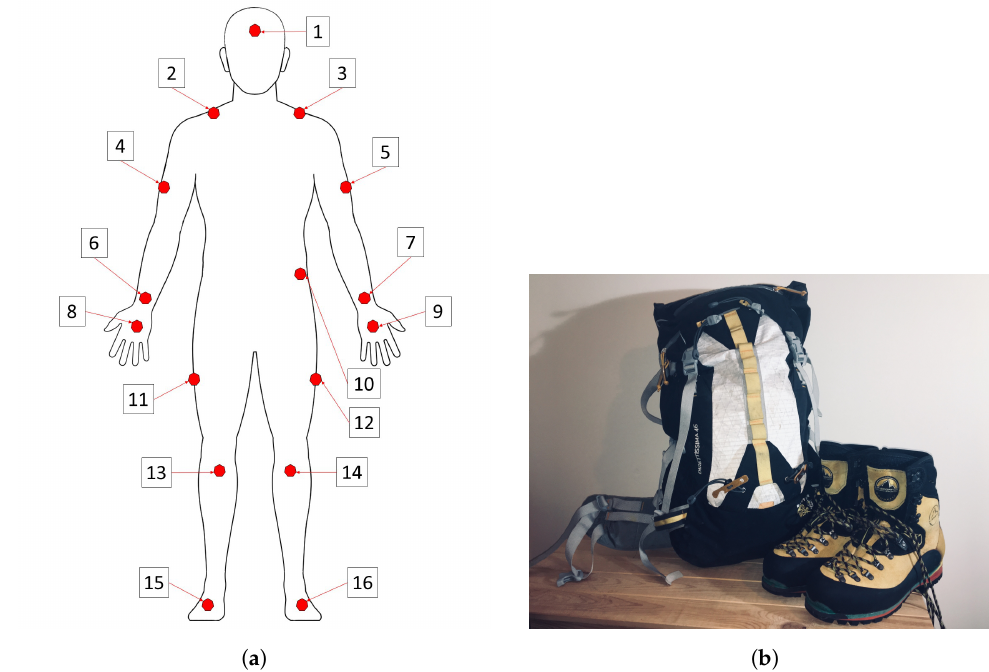
Figure 1. ( a ) Approximation of accelerometer placements from the Perception Neuron inertial motion capture (Mo-Cap) suit (Node 17: C7 vertebrae not shown). ( b ) Example of mountaineering rucksack (Mountain Hardwear, Direttissima 46) and B3 rated boots (LaSportiva, Nepal Evo